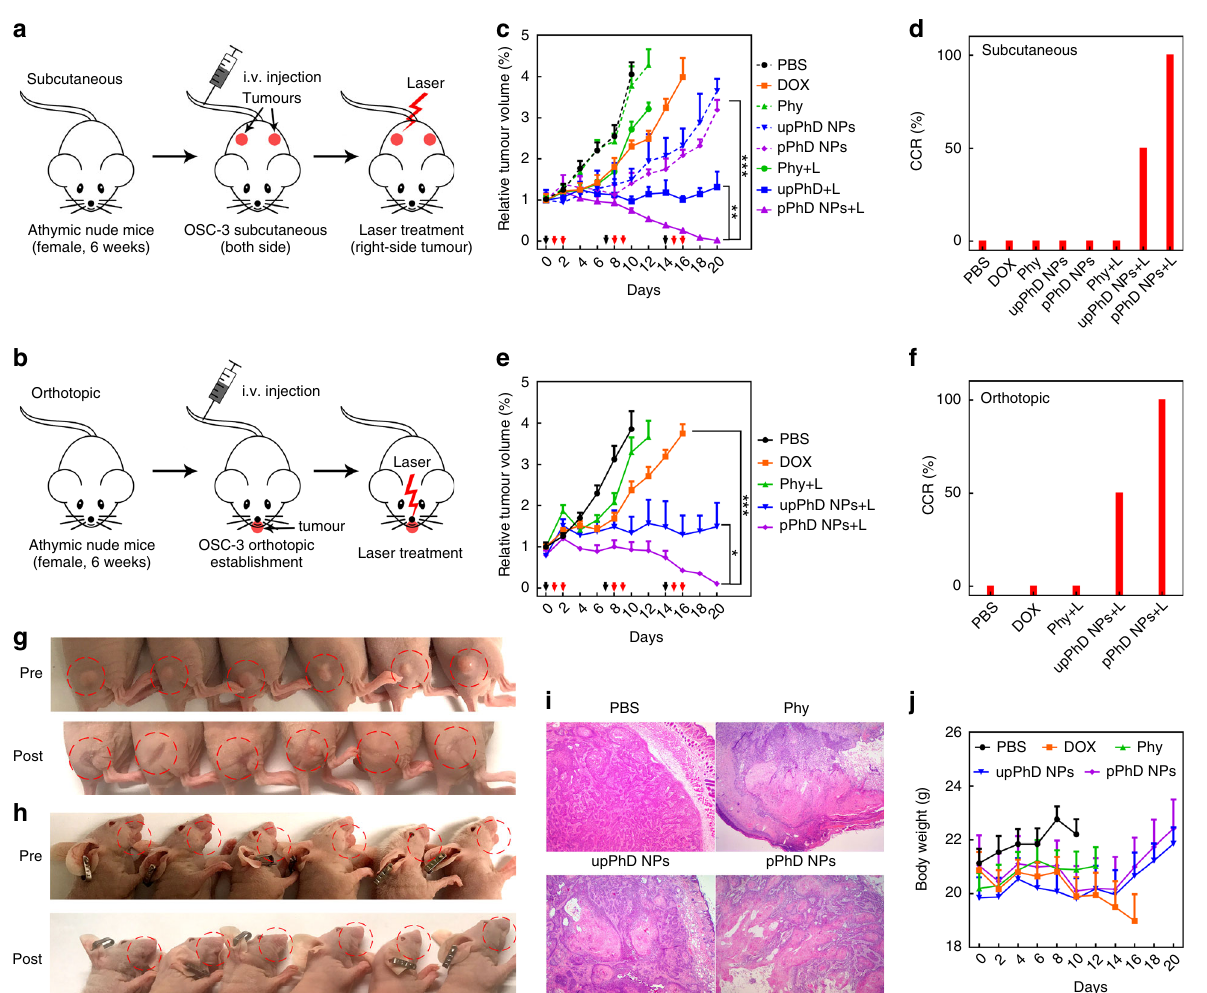
Fig. 5 Therapeutic effects of the nanoparticles. The establishment of a subcutaneous and b orthotopic oral tumour models ( n = 6), and the subsequent treatments with PBS, 4.7 mg kg − 1 DOX, 5.3 mg kg − 1 Phy, 10 mg kg – 1 upPhD NPs and 10 mg kg – 1 pPhD NPs (calculated based on the concentration of PhD monomer), respectively. The doses of free DOX and Phy were equivalent to those in upPhD NPs and pPhD NPs groups, respectively. The laser (680 nm) doses were all set as 0.4 W cm − 2 for 3 min. c The tumour volume changes on subcutaneous tumours ( n = 6) after administration of various treatment groups. The black arrows denote the nanoparticles administration, red ones point out the tumour treated by laser treatments. d The complete cure rate (CCR%) of the subcutaneous tumours. e The tumour volume changes on orthotopic tumours ( n = 6). f The CCR% of the orthotopic tumours treated with different groups. The images showed the tumour pro fi les of g the subcutaneous and h the orthotopic models, before (Pre) and after (Post) the pPhD NPs plus laser treatments. The mice were randomly aligned, the upper and lower panel may not correspond to each other. i H&E showed the histological changes induced by the in vivo phototherapeutic effect of photosensitizer-harboured materials. PBS group treated with laser was employed as control. The scale bar is 200 µ m. j Body weights changes ( n = 6) of tumour-bearing mice after treatment. * p < 0.05; ** p < 0.01; *** p < 0.001. All error bars are presented as standard deviation. Note: the mice were immunode fi cient, the laser treatments on right tumour were not able to induce immuno-responses